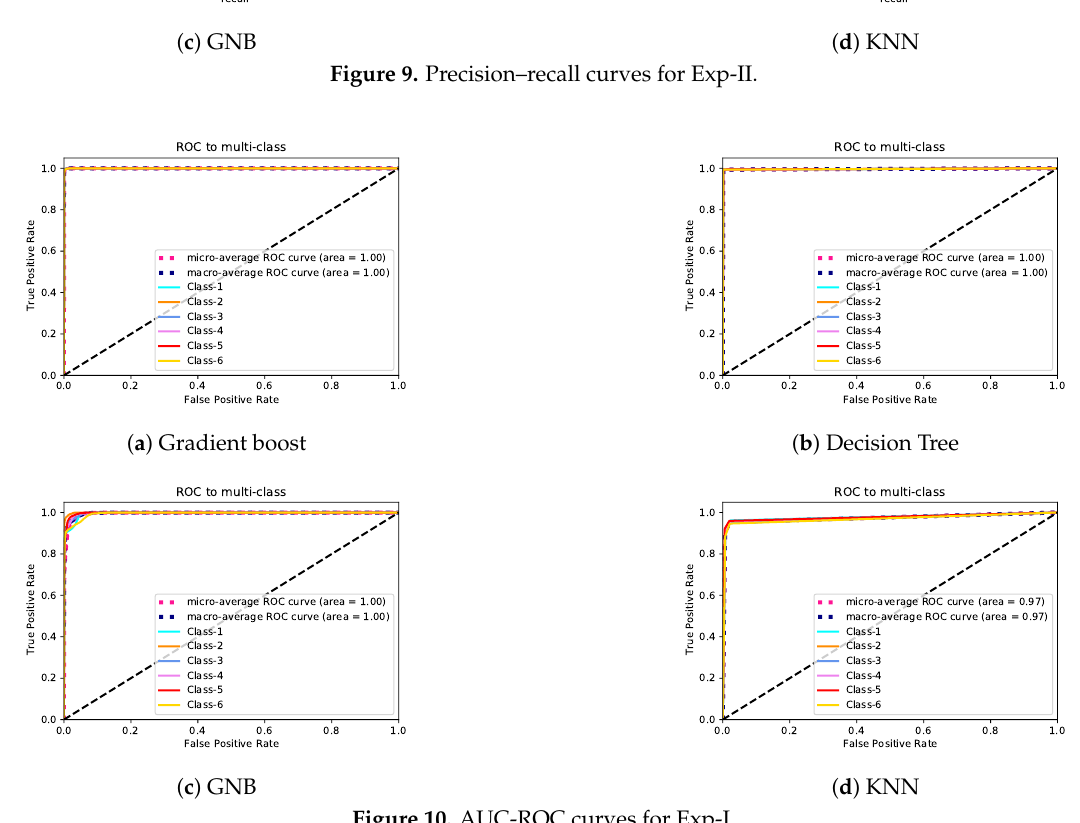
Figure 10. AUC-ROC curves for